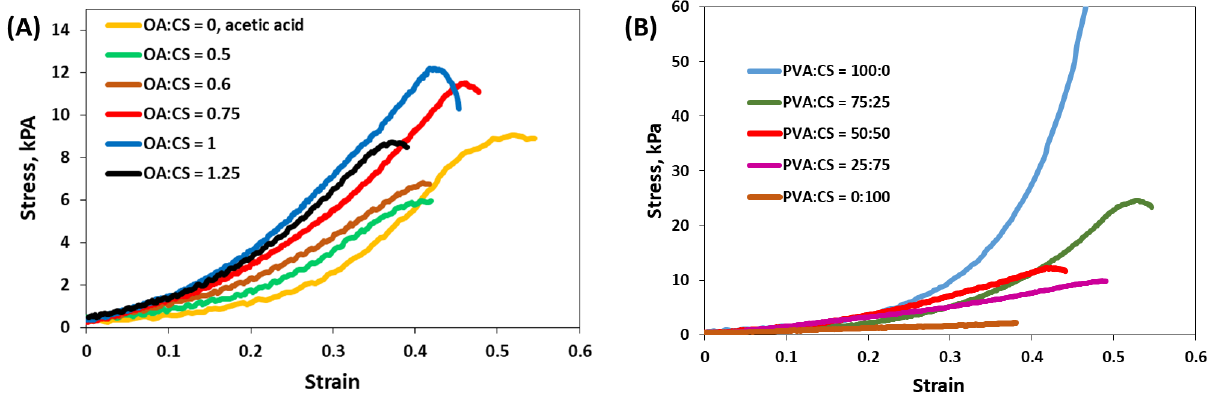
Figure 2. Stress–strain compressive curves for the PVA/CS/OA hydrogels: ( A ) the influence of the OA:CS wt. ratio for hydrogels obtained with PVA:CS = 50:50 (wt:wt) after 7 F-T cycles; ( B ) the influence of PVA:CS ratio for hydrogels obtained with OA:CS = 1:1 (wt:wt) after 7 F-T